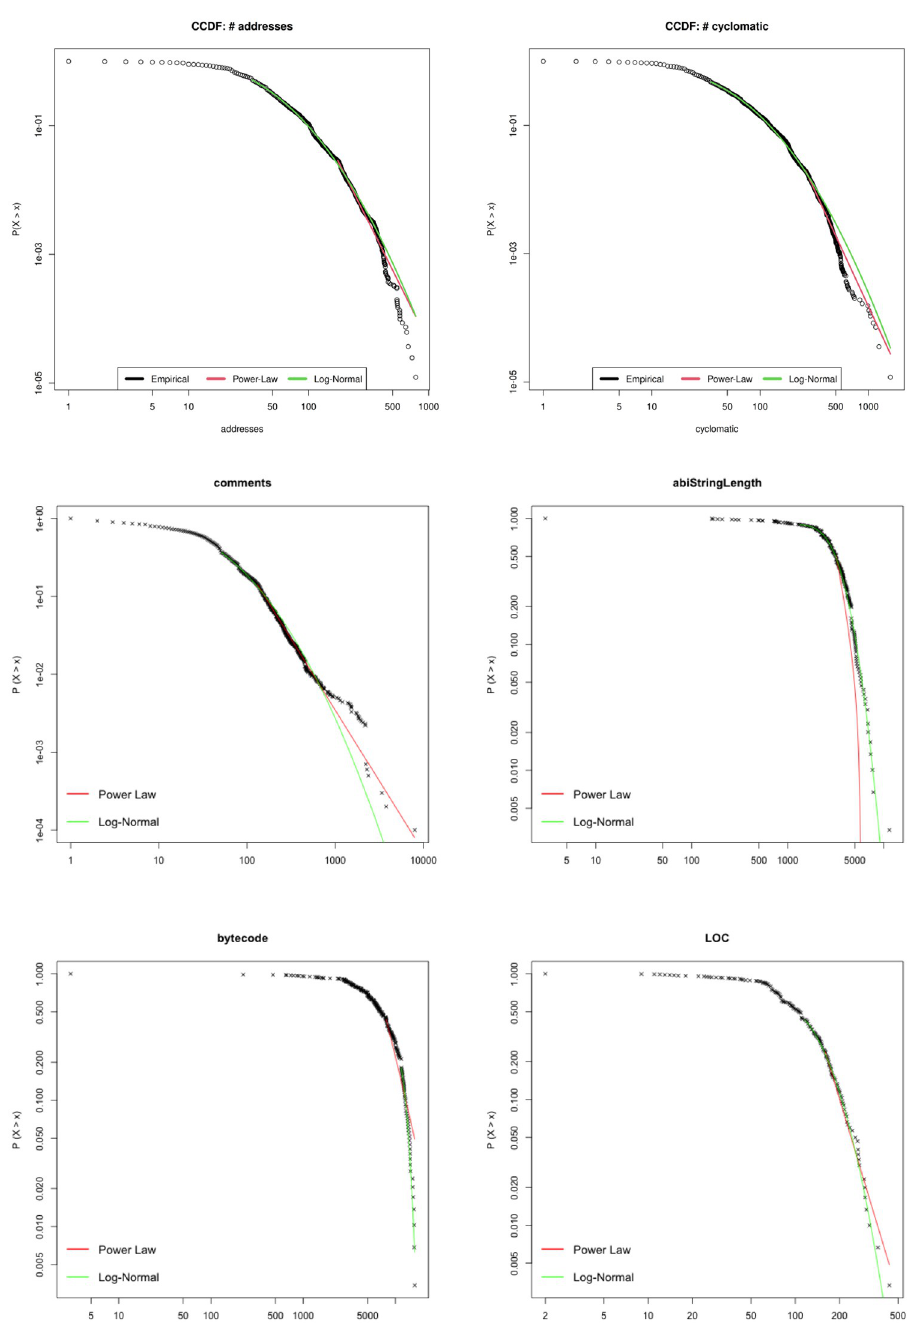
Fig 11. Power law and Log normal best fitting of the metrics Address, Cyclomatic, Comments, ABI, Bytecode and LOCS. https://doi.org/10.1371/journal.pone.0281043.g011 We validated our results using the bootstrap methodology in order to provide a 95% confi- dence interval for the estimated parameters. By default, the bootstrap function will use the Max Likelihood Estimator (MLE) to infer the parameter values and check all values of x The bootstrap procedure resamples the dataset with replacement for a large number of